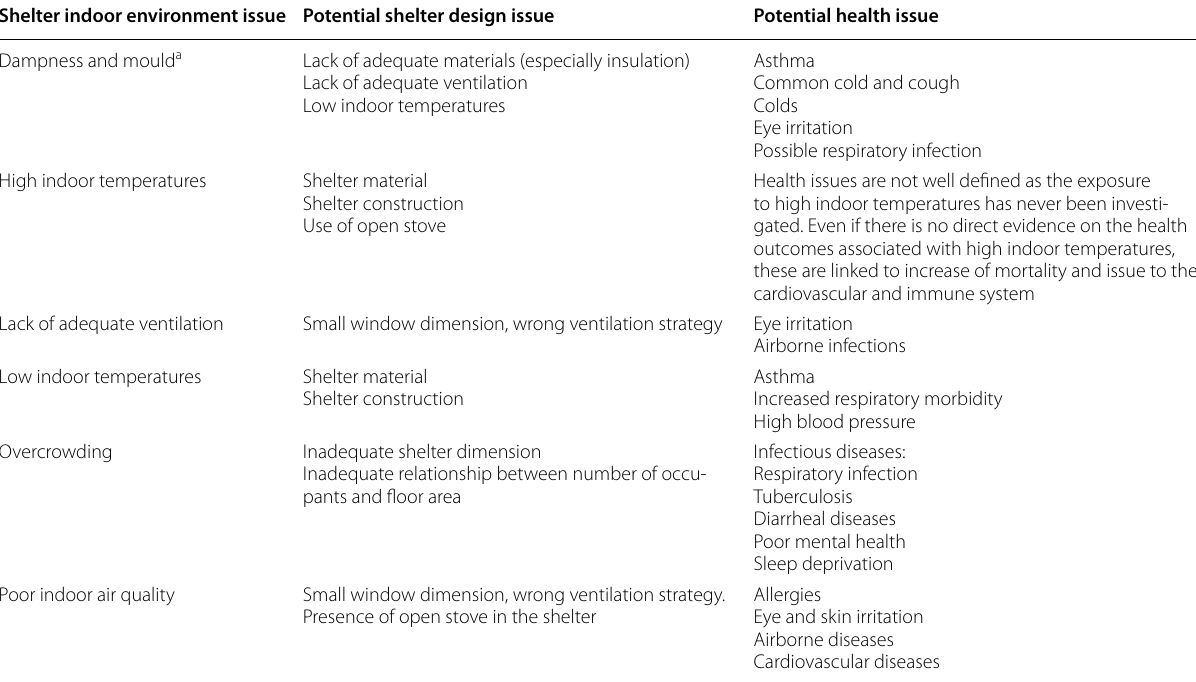
a Dampness and mould have been inserted as an independent factor in this table. However, their presence may be strongly related to the indoor temperatures and the indoor air quality and